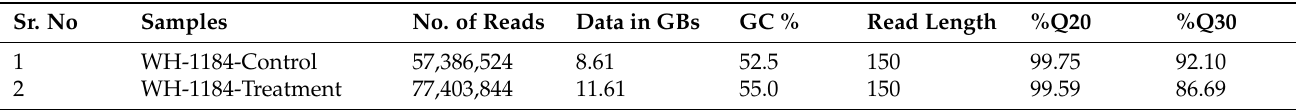
Table 2. Raw sequence data and quality check of raw reads.